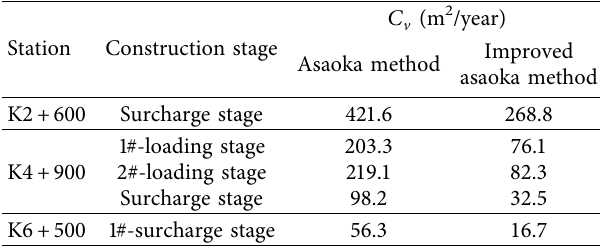
Table 4: Results of back analysis of consolidation parameter. Station